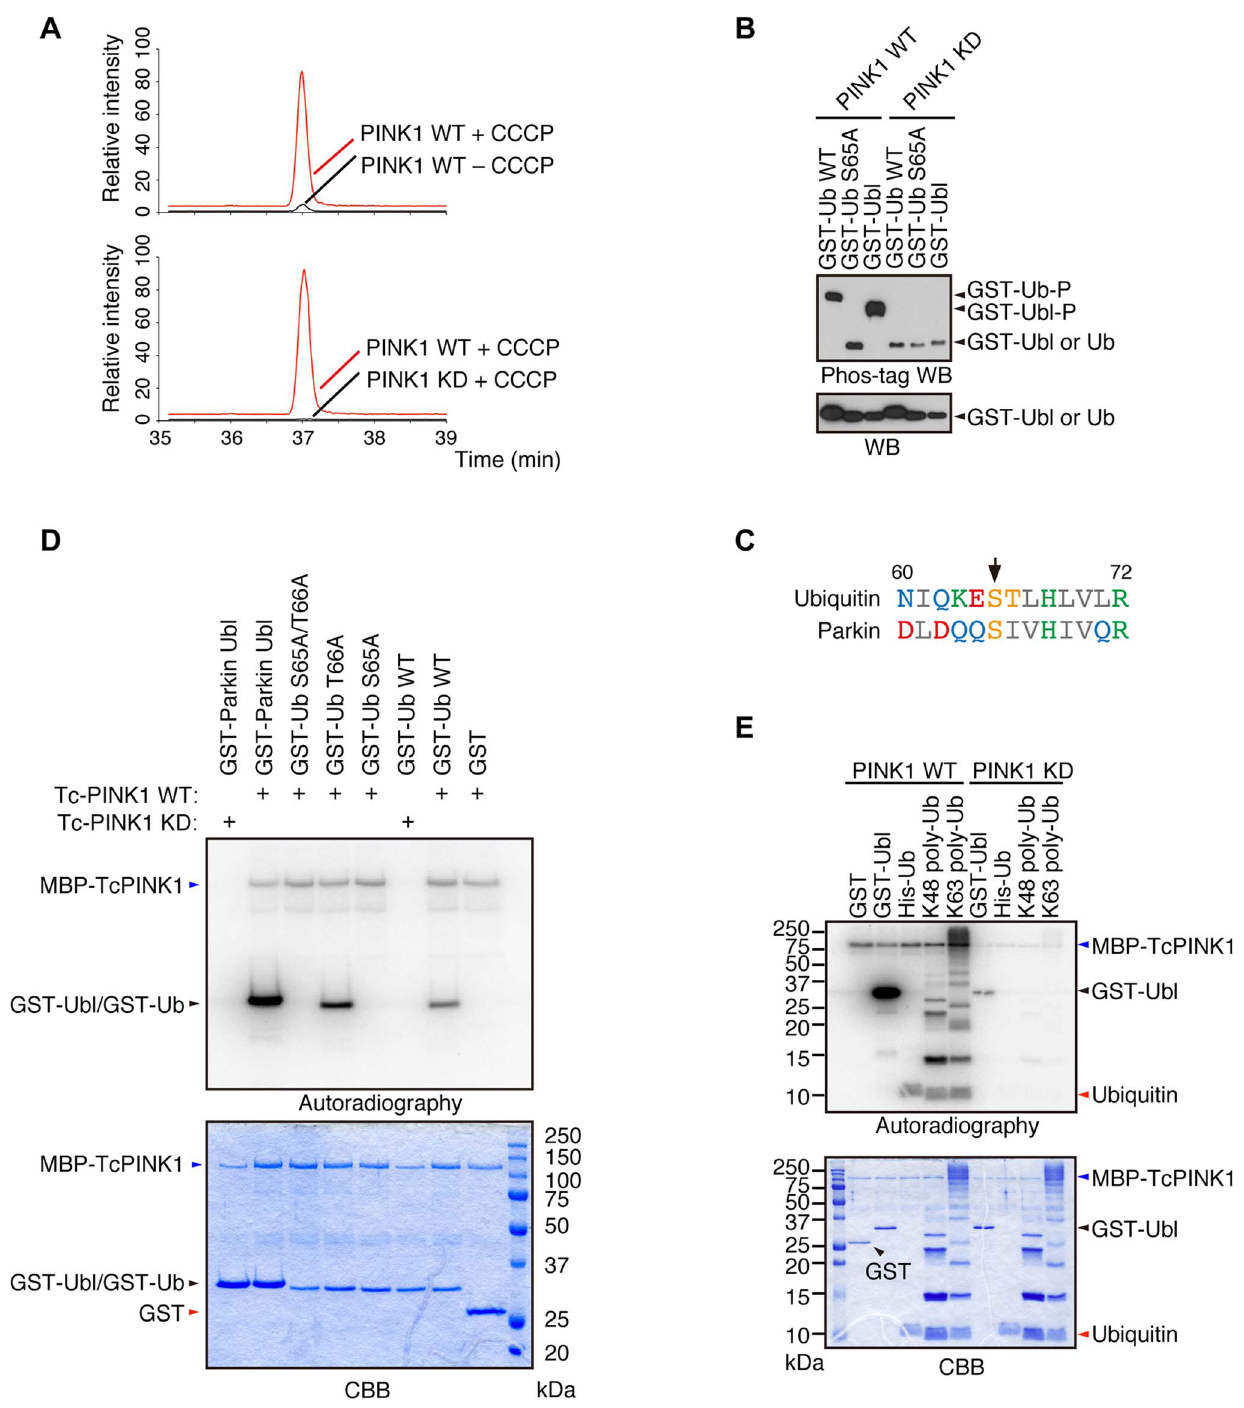
Figure 1. Ub is a substrate of PINK1. ( A ) Mass spectrometric screening of PINK1 substrates identified Ub phosphorylation at Ser65. Extracted ion chromatograms of dimethylated EpSTLHLVLR from mouse Ub phosphorylated by WT or KD PINK1 with or without CCCP treatment. Ub phosphorylation was specifically increased in PINK1-FLAG WT/ PINK1 2 / 2 MEFs treated with CCCP. The peak area ratios of PINK1 WT + CCCP to PINK1 WT – CCCP and PINK1 WT + CCCP to PINK1 KD + CCCP are 22.3 and 308.8, respectively. ( B ) Recombinant glutathione S-transferase (GST), GST-fusion Ub (Ub, WT and S65A) and GST-fusion Parkin Ubl domains were incubated with TcPINK1 WT or KD in 40 m l of kinase reaction buffer (50 mM Tris-HCl, pH 7.5, 0.1 mM EGTA, 10 mM MgCl 2 , 2 mM DTT and 2 mM ATP) for 90 min at 30 u C, and they were subsequently separated on a Phos-tag gel and a conventional polyacrylamide gel, followed by western blotting with anti-GST antibodies. ( C ) Alignment of the amino acid sequences surrounding Ser65 (marked by an arrow) from human Ub and human Parkin. The numbers correspond to the residue numbers in the Parkin and Ub proteins. Acidic, basic and hydrophobic amino acids are shown in red, green and grey, respectively. Amino acids with amido and hydroxyl groups are shown in blue and yellow, respectively. ( D ) Ser65 of Ub is the only site phosphorylated by PINK1. The GST, GST-Ub (WT, S65A, T66A and S65A/T66A) and Parkin Ubl domains were incubated with TcPINK1 WT or KD as in ( A ). The ATP source used was 10 m Ci of c - 32 P ATP. Phosphorylated Ub was detected by